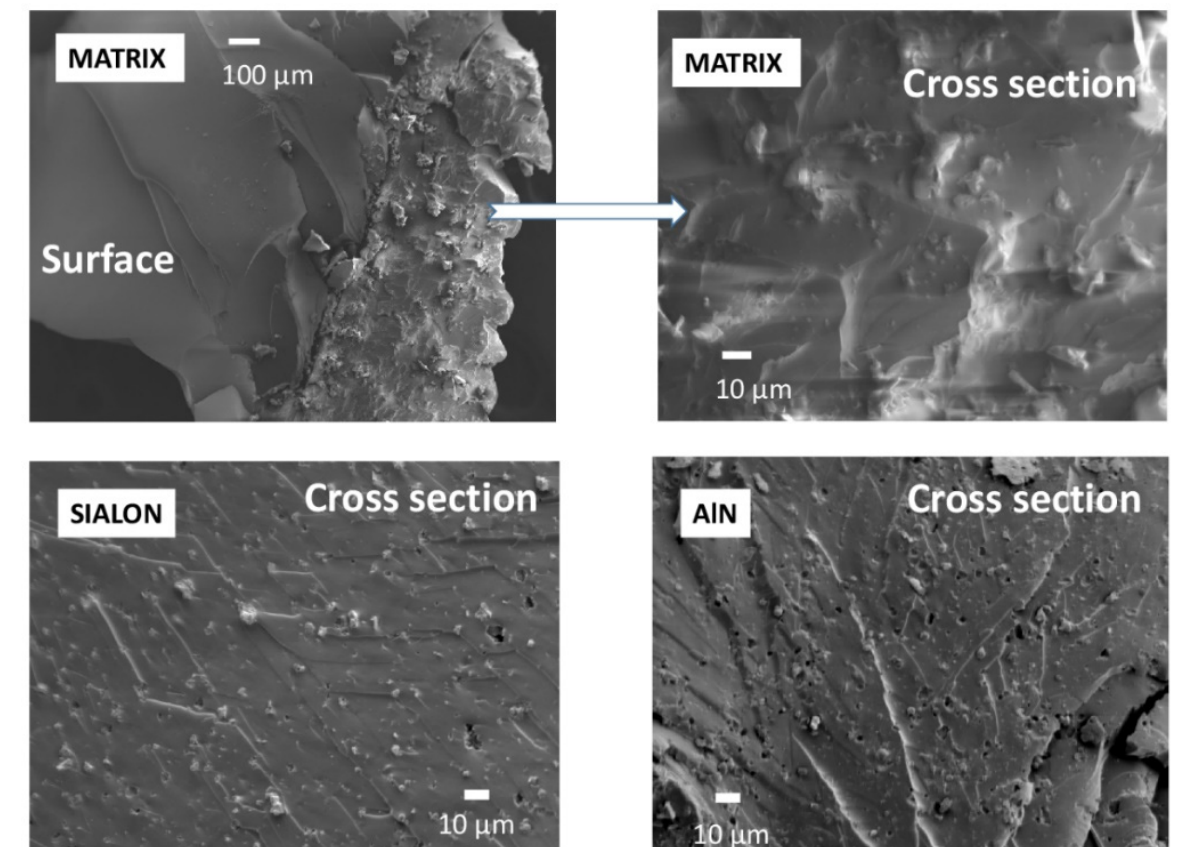
Figure 7. SEM micrographs of cross section of the sample composites containing AlN and Sialon particles. The filler content is 10 wt.%.